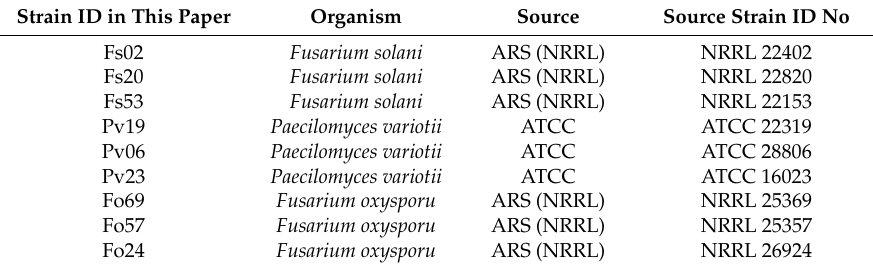
Table 1. List of all the strains used in this research with their corresponding